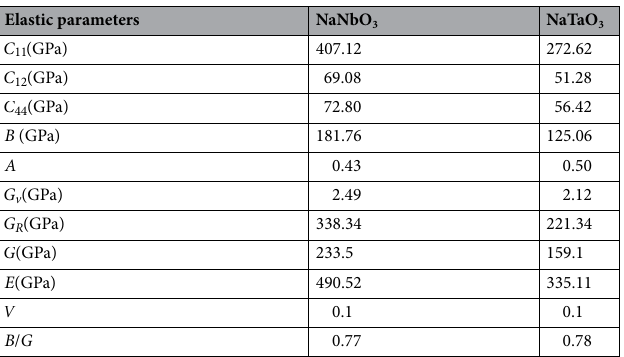
Table 2. Elastic parameters for the sodium niobate (NaNbO 3 ) and sodium tantalate (NaTaO 3 ): elastic stiffness coefficients ( C 11 , C 12 and C 44 ), bulk modulus (B) and Zener’s constant (A). G v , G R and G are Voigt shear modulus, Reuss shear modulus, and mean of G v and G R , respectively. E is the Elastic modulus, V is the Poisson’s ratio, B/G is the ratio of bulk to shear moduli. The elastic stiffness coefficients and other constants as well as pressure are in GPa and volume in bohr3.